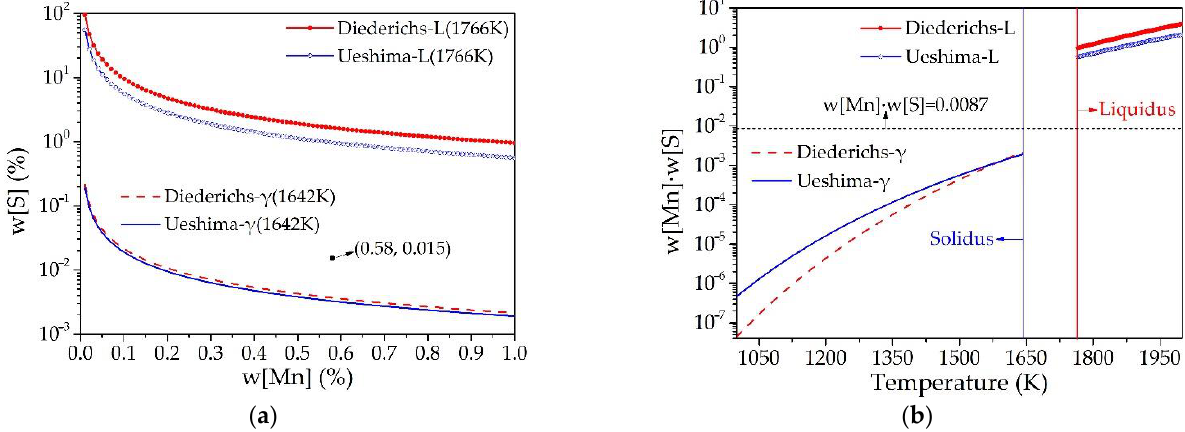
Figure 7. Thermodynamic calculation results of MnS inclusion formation in the medium carbon structural steel 45#. ( a ) Phase stability diagram of MnS, ( b ) equilibrium solubility product of MnS.